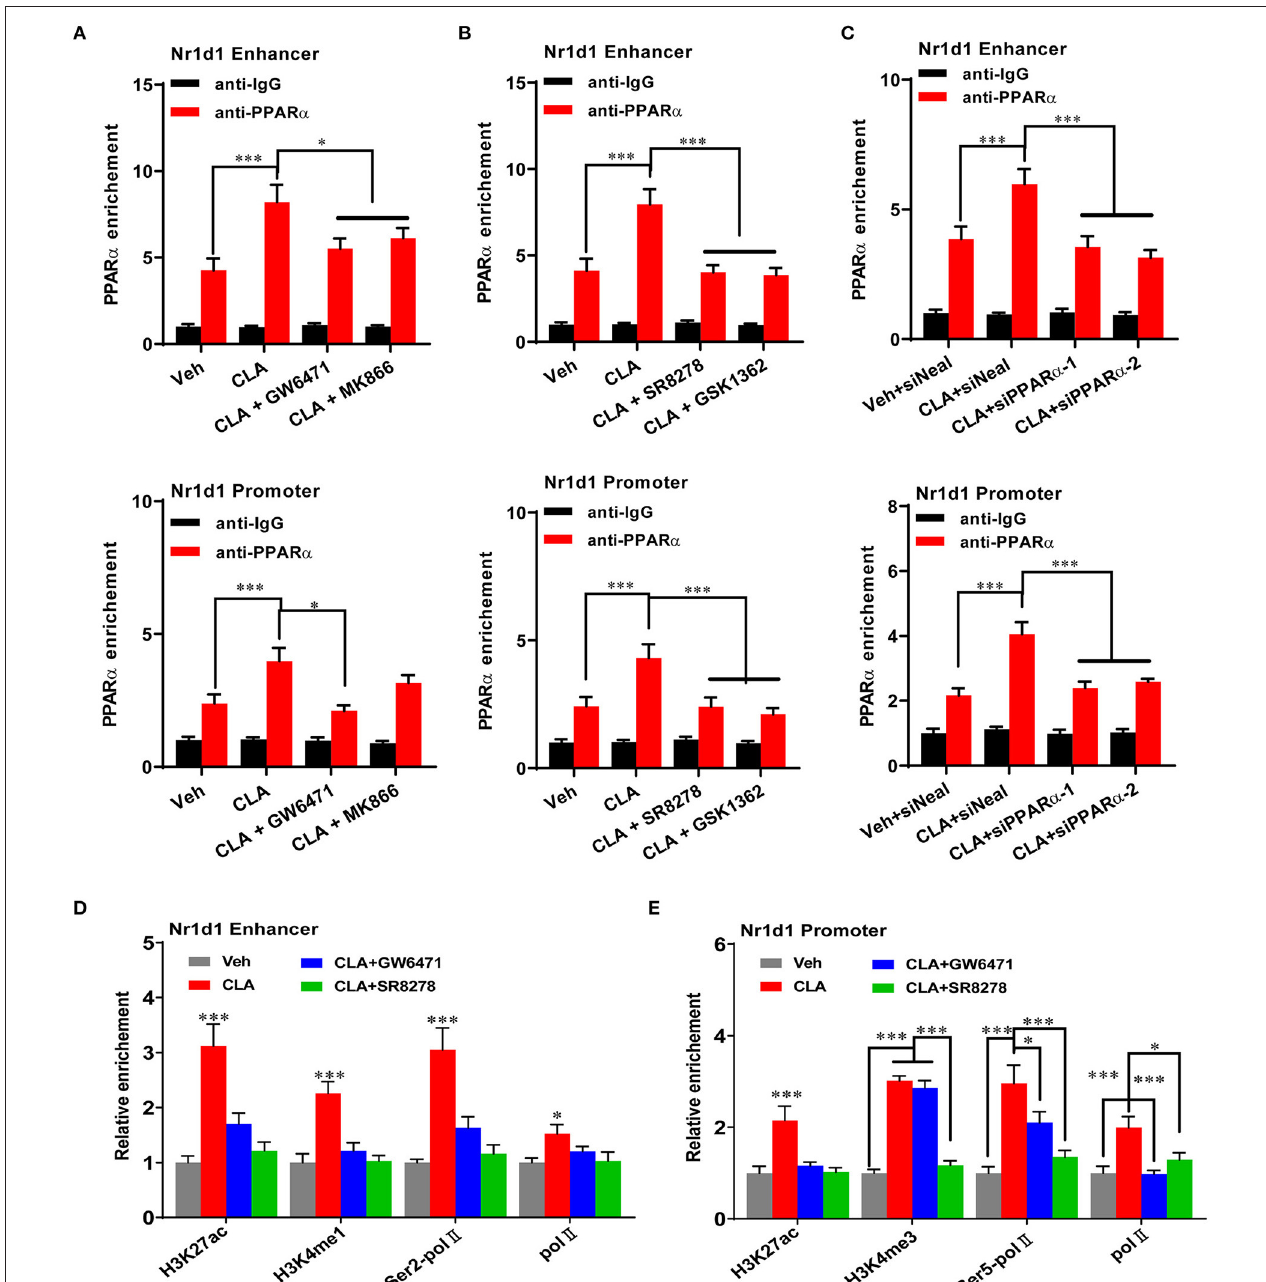
FIGURE 6 | PPAR α mediates REV-ERB α transcriptional activation. (A–C) PPAR α binding to the enhancer of Nr1d1 (upper panel) and the promoter of Nr1d1 (lower panel) determined by ChIP-qPCR in the hepatocytes of vehicle control, CLA, or cotreatment of CLA with PPAR α antagonists (GW6471, MK866) in (A) , or cotreatment of CLA with REV-ERB α antagonists (SR8278, GSK1362) in (B) , or CLA with PPAR α knockdown in (C) . (D) Relative enrichment of histone marks H3K27ac and H3K4me1, and Pol-II and Ser2P Pol-II recruitment at the enhancer of Nr1d1 . (E) Relative enrichment of histone marks H3K27ac and H3K4me3, and Pol-II and Ser5P Pol-II recruitment at the promoter of Nr1d1 . The data are shown as the means ± SD, n = 6 per group. The experiments were repeated three times. * p < 0.05, *** p < 0.001, using ANOVA with Tukey’s post-hoc